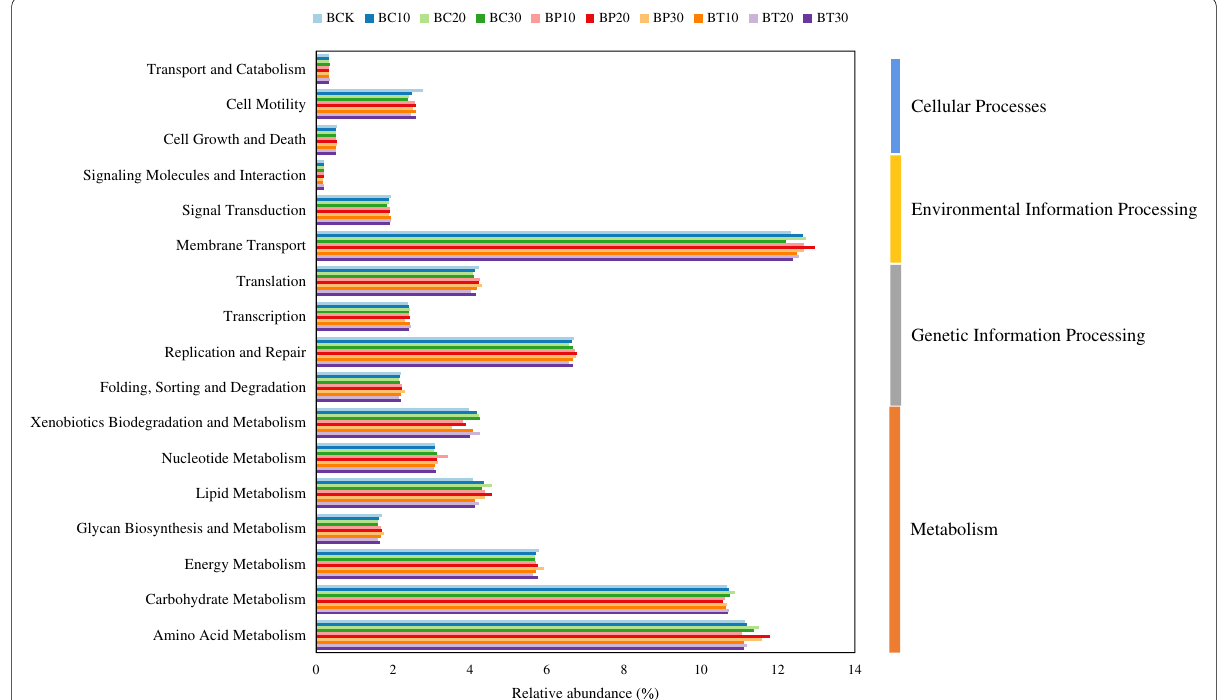
Fig. 5 The abundance of the metabolic functions of the bacterial communities at the second classification